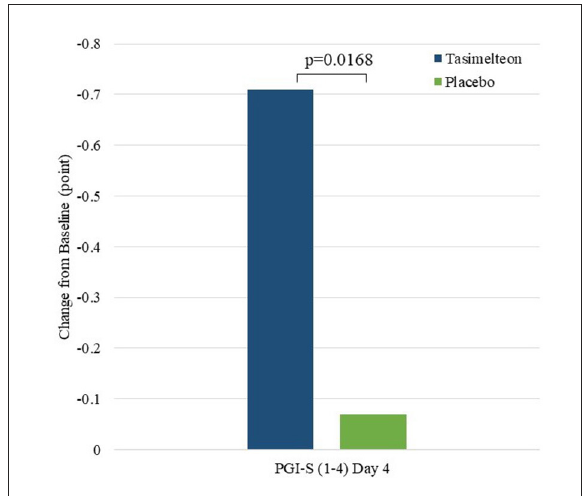
FIGURE5 Global functioning (Day 4)—change from